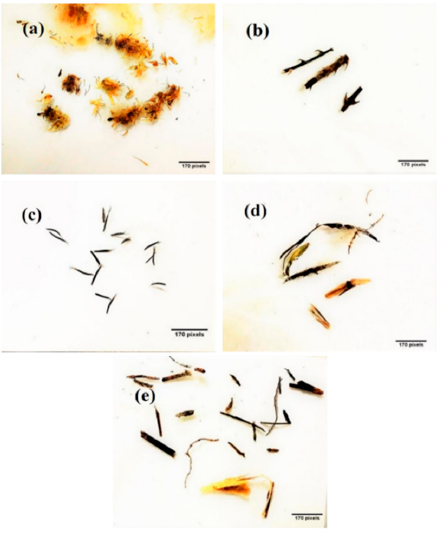
Figure 6. Different types of vegetable matter ( a ) Setaria grass; ( b ) Thistles; ( c ) Bidens Pilosa; ( d ) Pasture grass; ( e ) Small sticks.